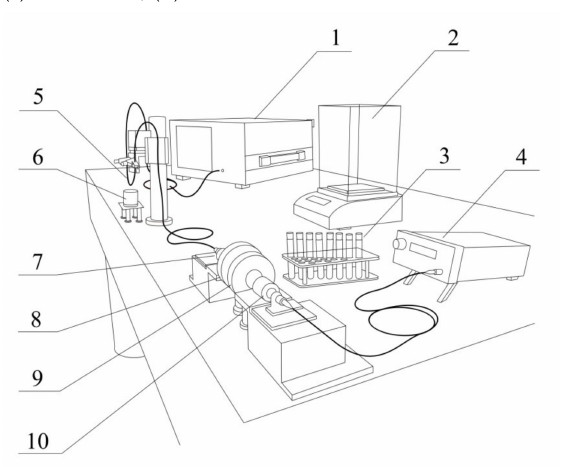
Figure 24. Measurement system scheme: 1—optical spectrum analyzer, 2—electronic scales, 3—test tubes with glucose solutions, 4—superluminescent diode, 5—TTFBG and P-TFBG sensors, 6—test solution, 7—microscope lens, 8—half wave plate mounted in rotation base, 9—polarizer, 10—microscope